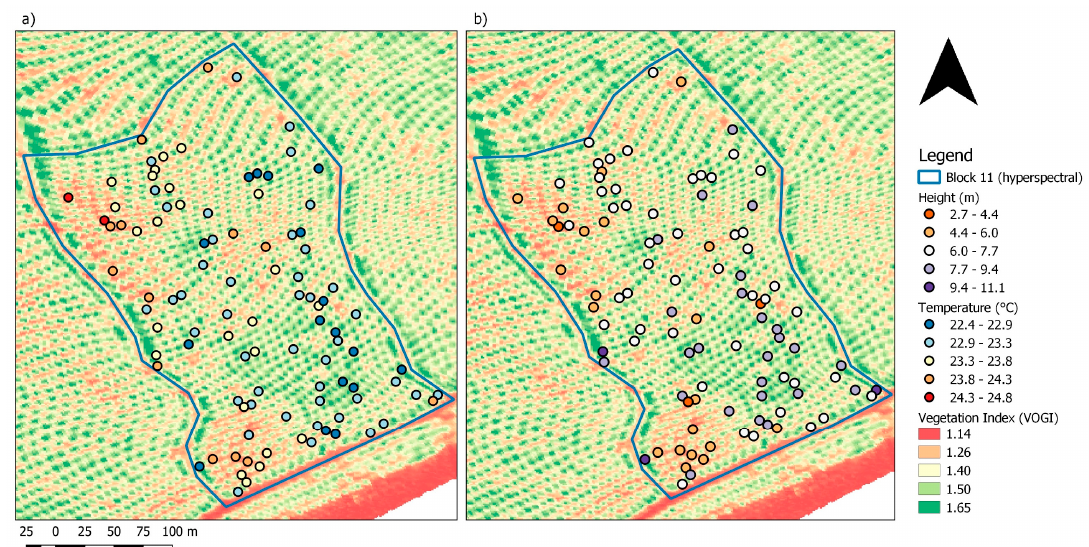
Figure 11. Illustration of the spatial patterns between tree-based point observations of ( a ) temperature and ( b ) height, with the vegetation index VOGI visualized as background map for